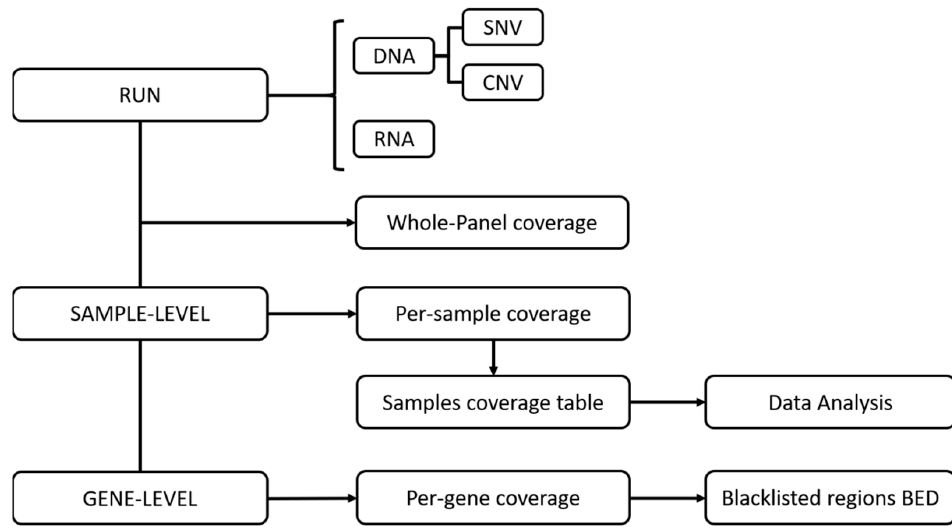
Figure 1. Coverage analysis